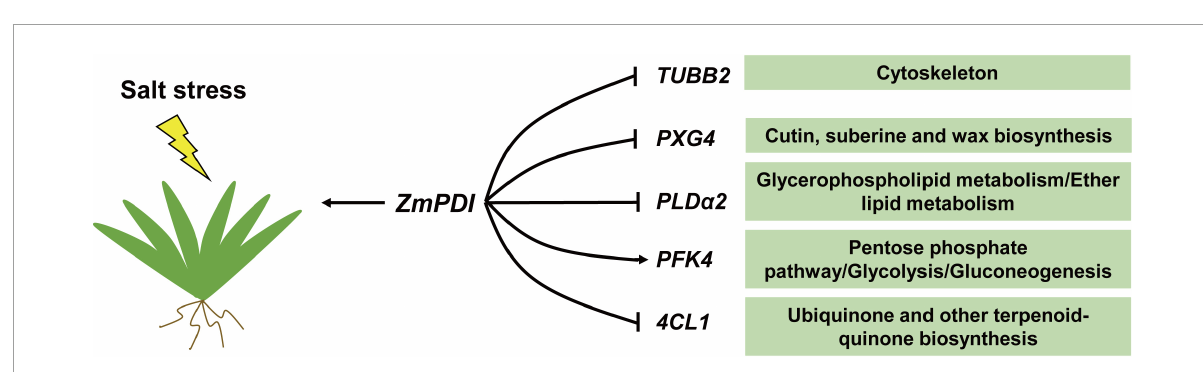
Table 5 ). In the ZmPDI24h vs. ZmPDI0h comparison, the